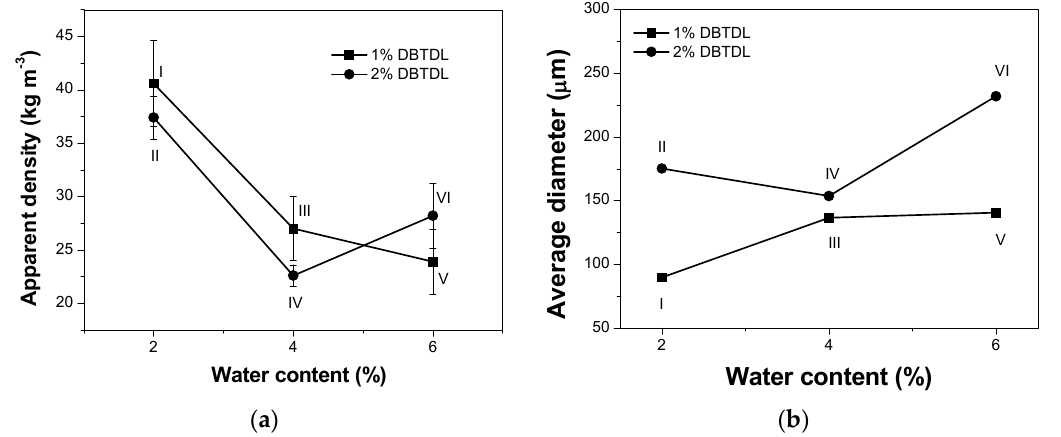
Figure 5. ( a ) Apparent density and ( b ) the average diameter of foams with different contents of the blowing agent (water) and catalyst. The numbers corresponding to the foam formulations (Table 1) are indicated in each point of these graphics.